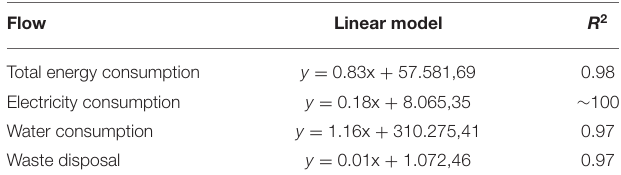
TABLE 2 | Linear models of metabolic flows with respect to GDP.